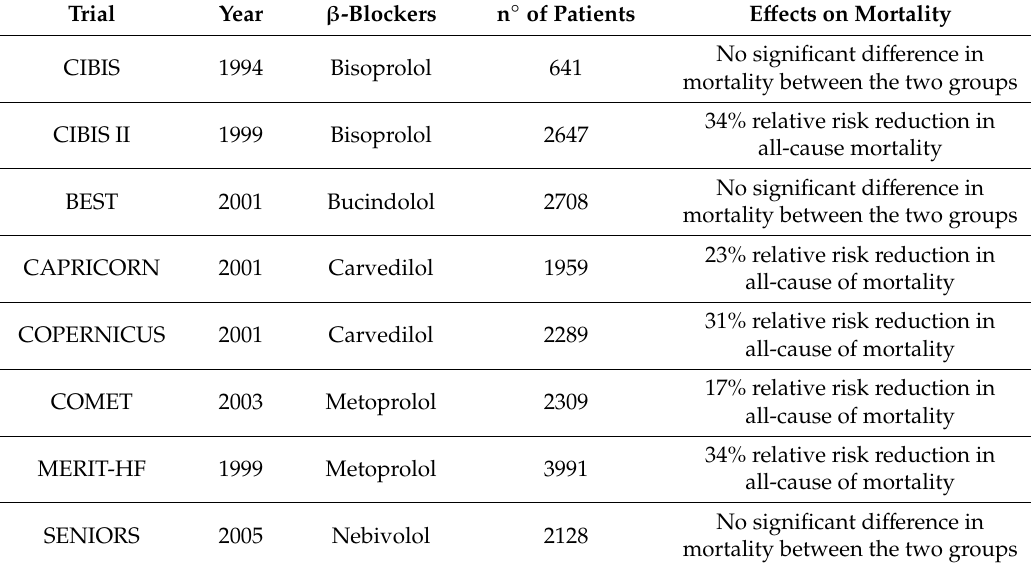
Table 1. Summary of randomized clinical trials of β -blockers in heart failure reduced ejection